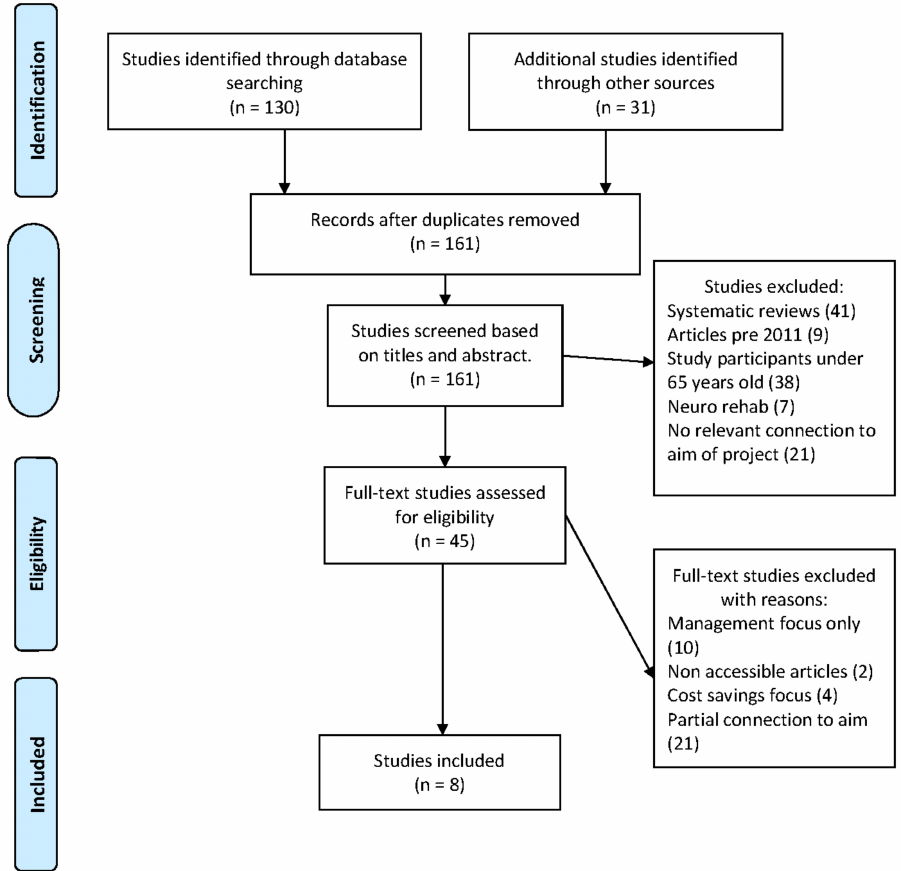
Figure 1. Preferred Reporting Items for Systematic Reviews and Meta-Analyses (PRISMA) (2009) Flow Diagram showing the findings of the systematic